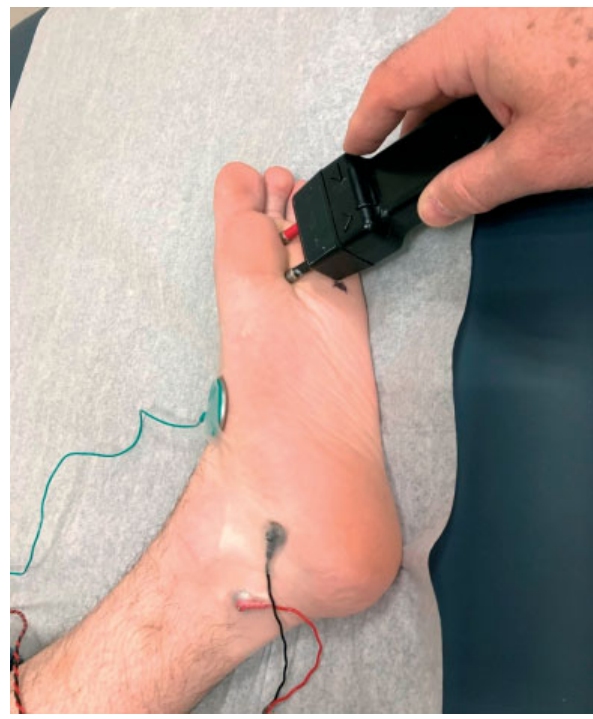
Fig. 2 Cathode (black) stimulation of medial plantar MNAP just proximal to the metatarsal heads between the fi rst and second metatarsals with E1 (black) 14-cm proximal across the tarsal tunnel on the tibial nerve. Lateral plantar stimulation is achieved by moving the cathode tothe mark between the fourth and fi fth metatarsals with the same E1 distance and setup. MNAP, mixed nerve action potential.